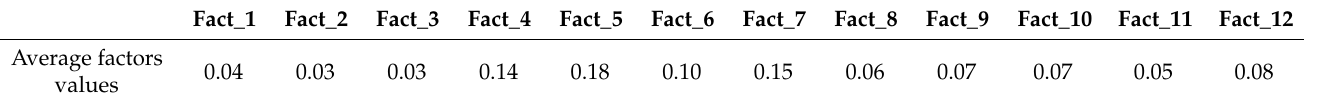
Table 4. Average factors values from the point of view of the surveyed